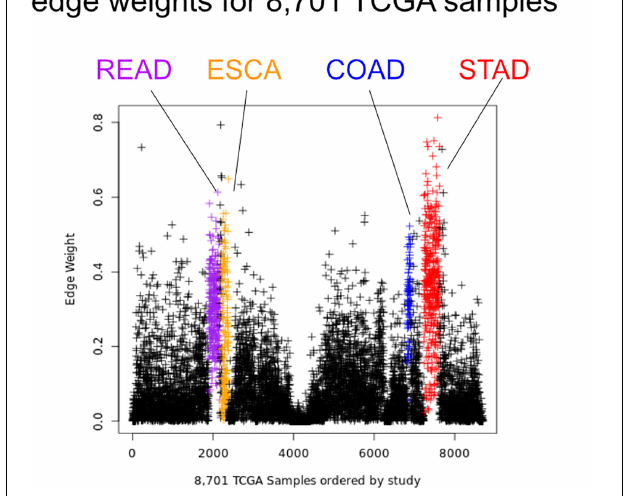
FIGURE 5 | Edge weights can distinguish tissue types. Each point represents a tumor sample, sorted by tissue type. Shown is the Th2 cell-IL4-IL2RG-Megakaryocytes edge colored by tissue source: STAD red, READ blue, COAD purple, and ESCA